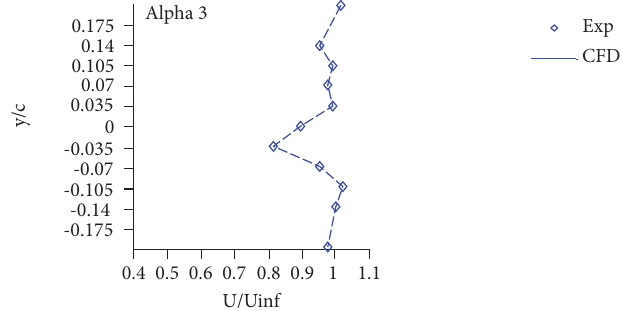
Figure 27. Streamwise velocity profile, pitch motion α (t) = 3 + 3 sin( w t), frequency = 3 Hz, Mach =